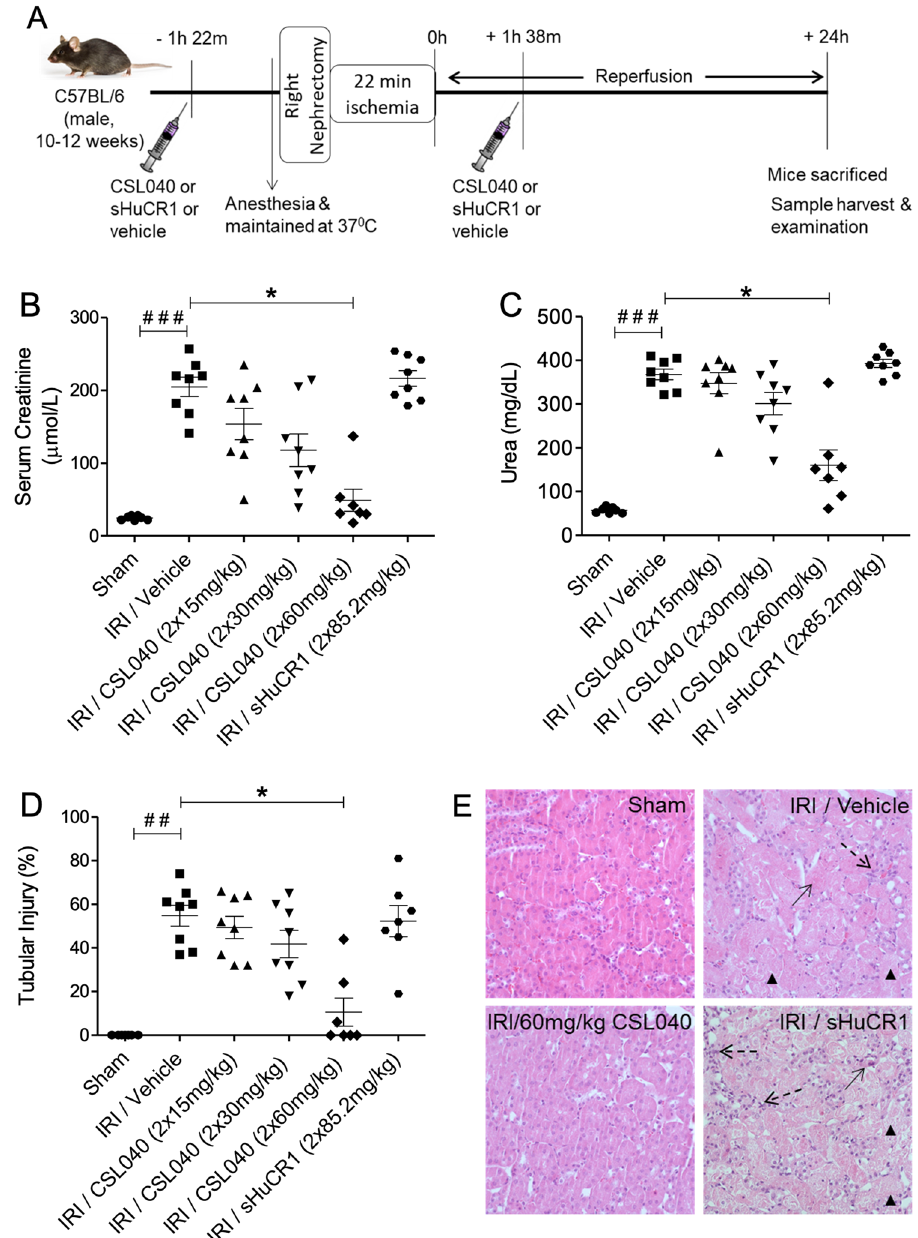
Figure 2. Protection against IR-induced renal dysfunction by CSL040 treatment. ( A ) A schematic illustration of the experimental setup and time course of the mouse model. Mice were treated with two doses of vehicle control, 15–60 mg/kg CSL040, or 85.2 mg/kg sHuCR1 as indicated 1 h prior to ischemia and 3 h after the first injection. Twenty-four hours after reperfusion, renal function was assessed by measuring ( B ) serum creatinine and ( C ) urea, and ( D ) tubular injury in kidney sections. ( E ) Representative images of hematoxylin–eosin (H&E) stained kidney sections used to score renal tubular injury (×400 magnification). Arrowheads indicate tubular injury, necrosis, swell and dilation; arrows indicate cast formation; dashed arrows indicate inflammatory cell infiltration. Significance was tested using Mann–Whitney U test ( ## p < 0.01, ### p < 0.001 for sham vs. IRI/vehicle), and One-way ANOVA Kruskal–Wallis and Dunn multiple comparisons test (*p < 0.05 for IRI/vehicle vs. all treatments). The data shown are mean ± SEM (n = 7–8 per